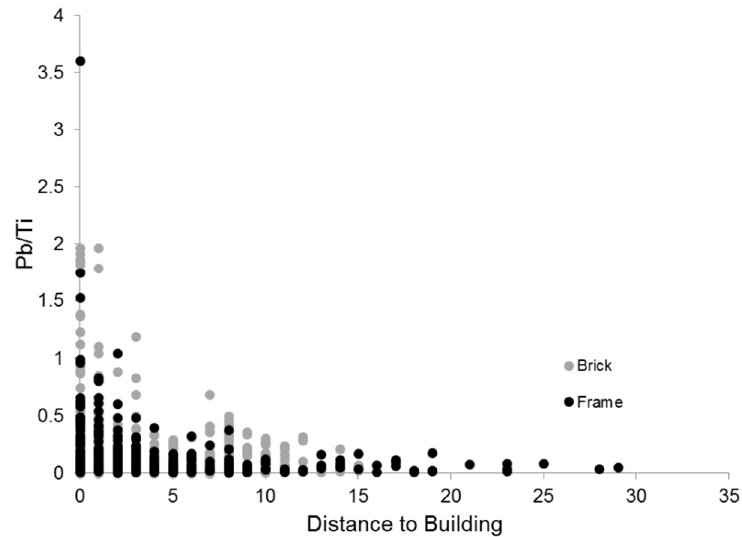
Figure 5. Lead/titanium ratios and distance to building. Ratios are higher close to the building and decrease with distance. Ratios greater than one highlight the possibility of multiple sources of lead in the soil. Date source: [49].